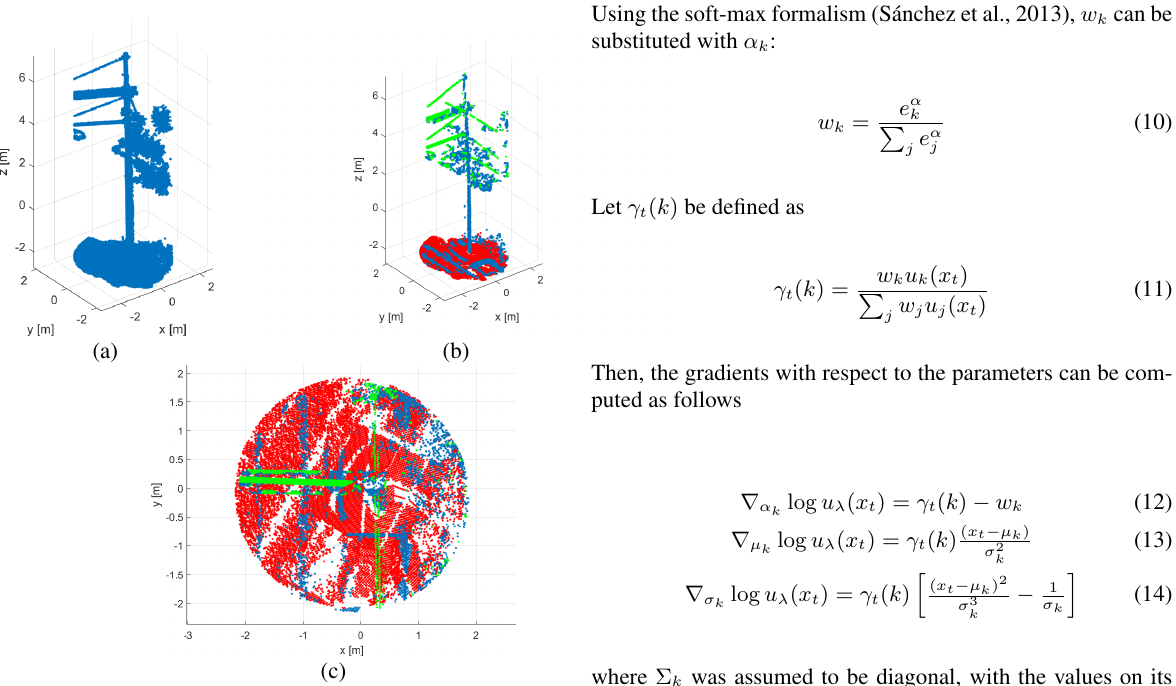
Figure 6. Example of point cloud pre-processing (discarding wall): (a) and (b) original data, (c) segmentation side view, mast (blue), cantilever and wires (green), ground (red), (d) segmentation re-oriented top view.